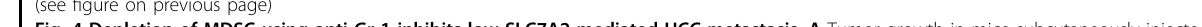
Fig. 4 Depletion of MDSC using anti-Gr-1 inhibits low SLC7A2 mediated HCC metastasis. A Tumor growth in mice subcutaneously injected with Hepa1-6-shcontrol or Hepa1-6-shSLC7A2 cells, treated with anti-Gr-1 antibody (400 μ g/body) or IgG twice a week from day 1 after tumor inoculation. n = 10. B Flow cytometric images of subcutaneous Hepa1-6-shcontrol or Hepa1-6-shSLC7A2 cells treated with anti-Gr-1 antibody or IgG at day 27. CD8 + T cells (upper) and MDSCs (lower). C Flow cytometric analyses the ratio of CD8 + T cells and MDSCs between groups at day 27 respectively, n = 10. The data are shown as the mean ± SD from the at least three independent experiments; ** P < 0.01. D – H In vivo assays shown that MDSCs depletion could suppress loss of SLC7A2-mediated HCC metastasis. D The representative Bioluminescence images were shown in the different groups, treated with anti-Gr-1 antibody or IgG in the C57BL/6 injected with the indicated cells in the liver, n = 10. E The Bioluminescence intensity in the tumors at the indicated time point was presented as the total photon fl ux. F Incidence of lung metastasis and the number of metastatic lung nodules in lung in the C57BL/6 mice. n = 10. G Overall survival of the mice in each group. H Representative H&E-stained lung metastatic nodules. The scale bars represent 1 mm (upper panel) and 100 μ m (lower panel). The data are shown as the mean ± SD; * P < 0.05 and ** P <